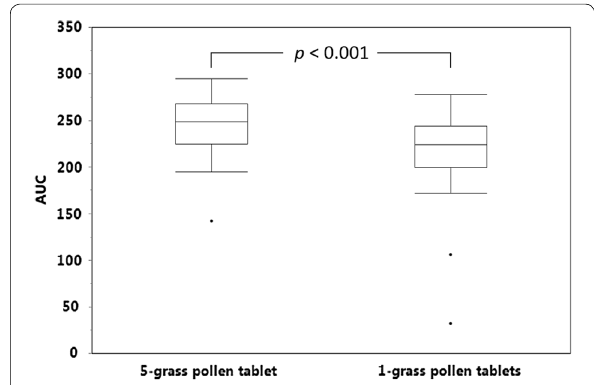
Fig. 4 AUCs obtained with one 5-grass pollen tablet and three 1-grass pollen tablets. AUCs were obtained in ELISA-inhibition experiments using microtiter plates coated with a 12-grass pollen extract and detection of serum IgE from both Spanish and Swedish patients ( n 41). The p -value was obtained with the two-sided = Wilcoxon signed rank test